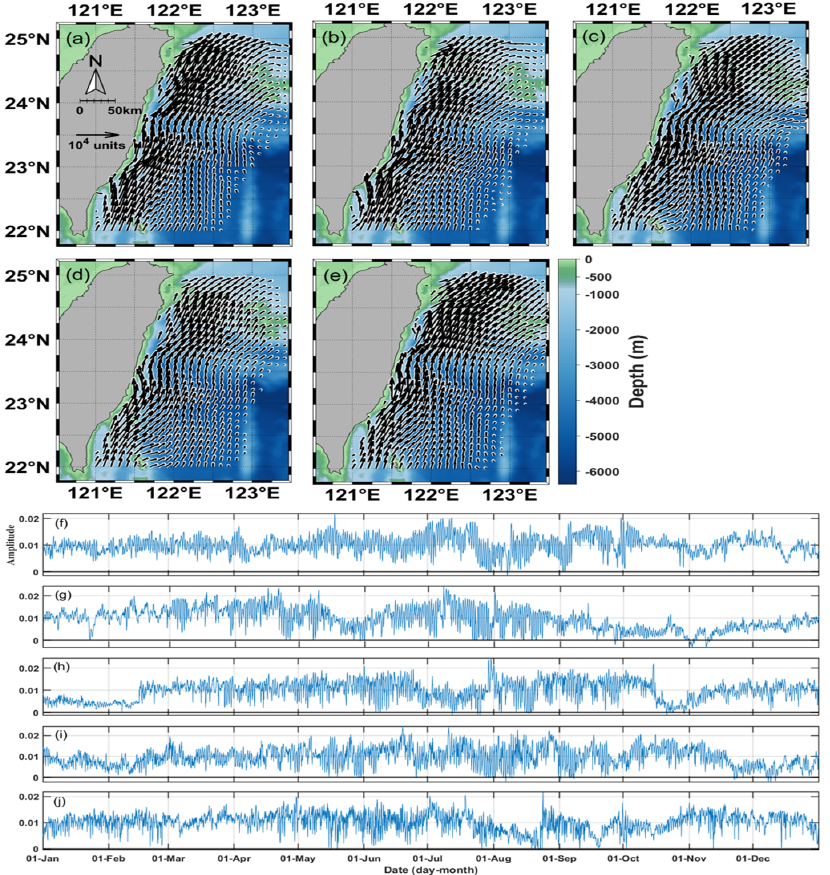
Figure 6. The EOF1 of Kuroshio region. ( a – e ) The spatial modes from 2015 to 2019. ( f – j ) The time series of principal components from 2015 to 2019.